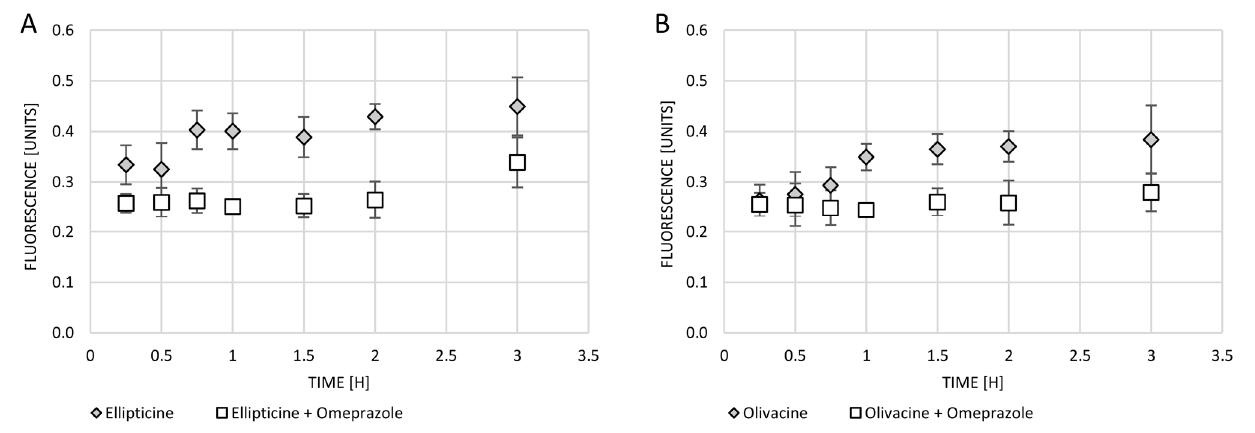
Figure 5. Changes in fluorescence intensity in the supernatant collected from A549 cells over time after treatment with: ( A ) ellipticine (10 μ M) or ellipticine (10 μ M) and omeprazole (200 μ M); ( B ) olivacine (10 μ M) or olivacine (10 μ M) and omeprazole (200 μ M).